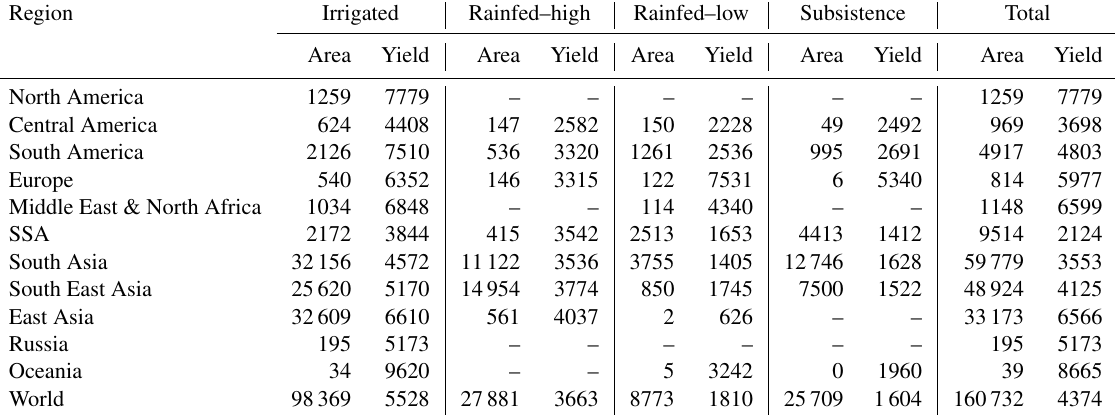
Table 3. Regional values for area and yield of rice from SPAM2010. Unit: area (1000 ha); yield (kg / ha).